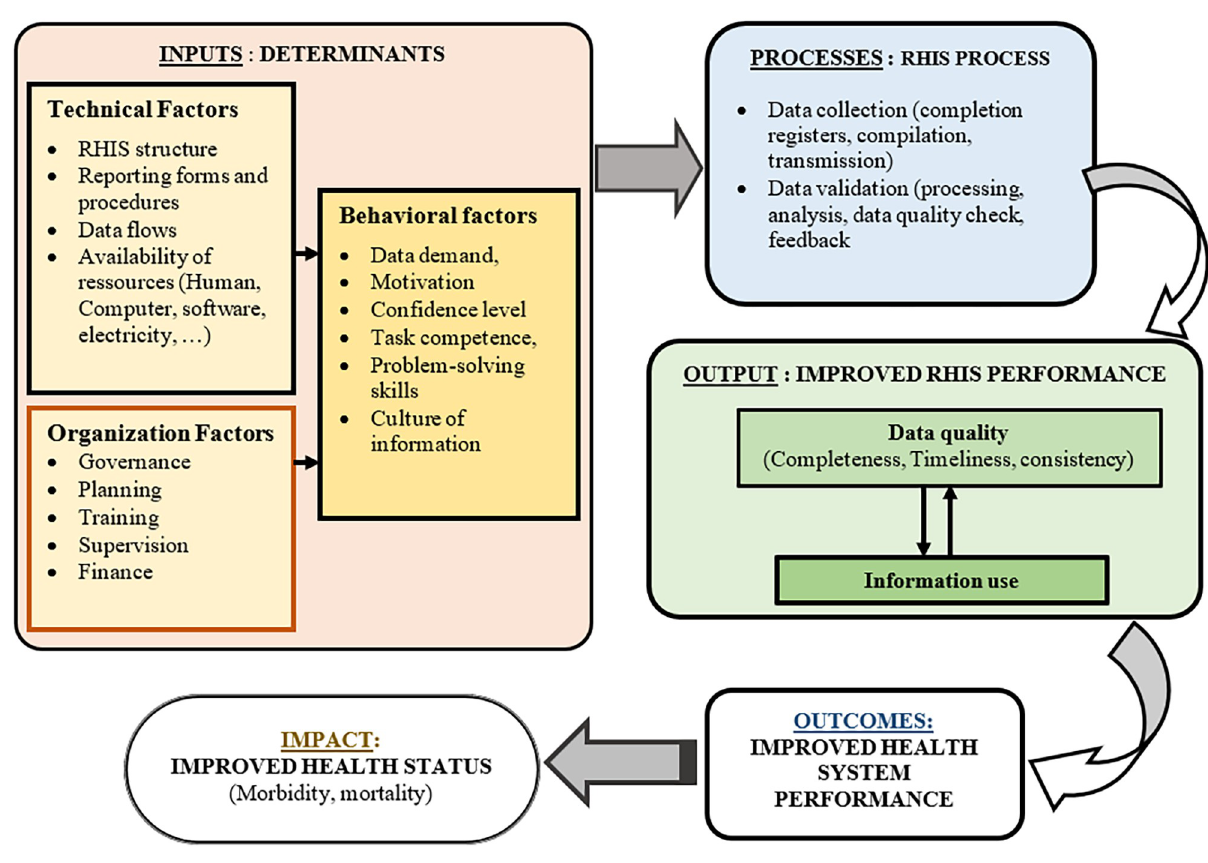
Fig 1. PRISM conceptual